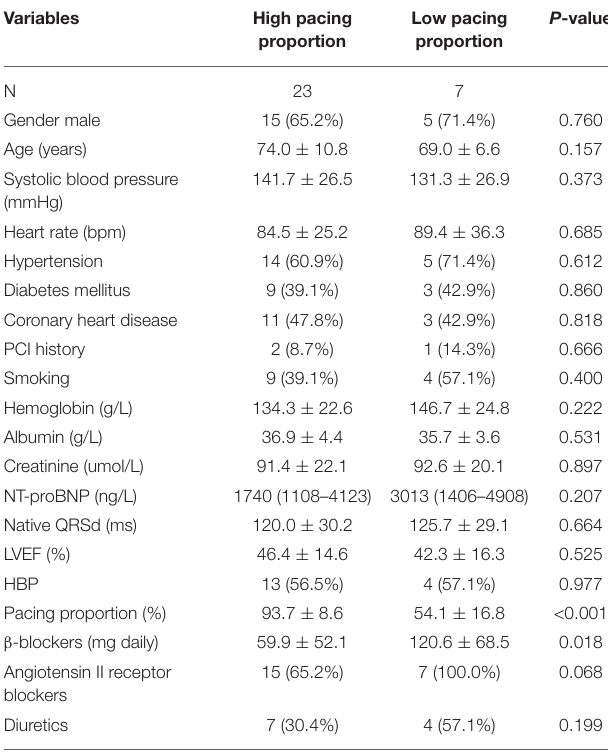
TABLE 1 | Baseline clinical characteristics of patients under high and low pacing